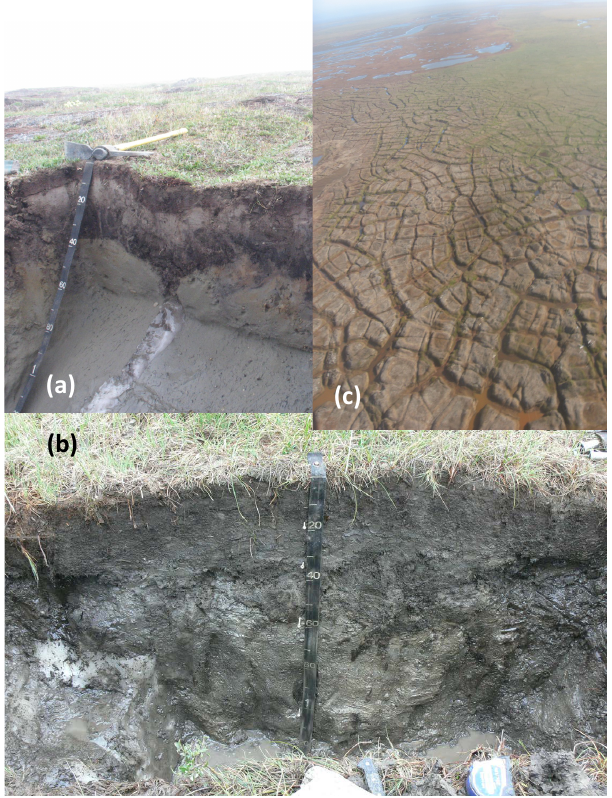
Figure 2. Soils formed in ice-wedge polygons: (a) active layer deformed by newly formed ice wedge (7cm wide); (b) cryotur- bated polygon rim of a flat-centered ice-wedge polygon (ice wedge is 85cm wide); and (c) an aerial view of the ice-wedge polygon- dominated landscape of the Arctic Coastal Plain,